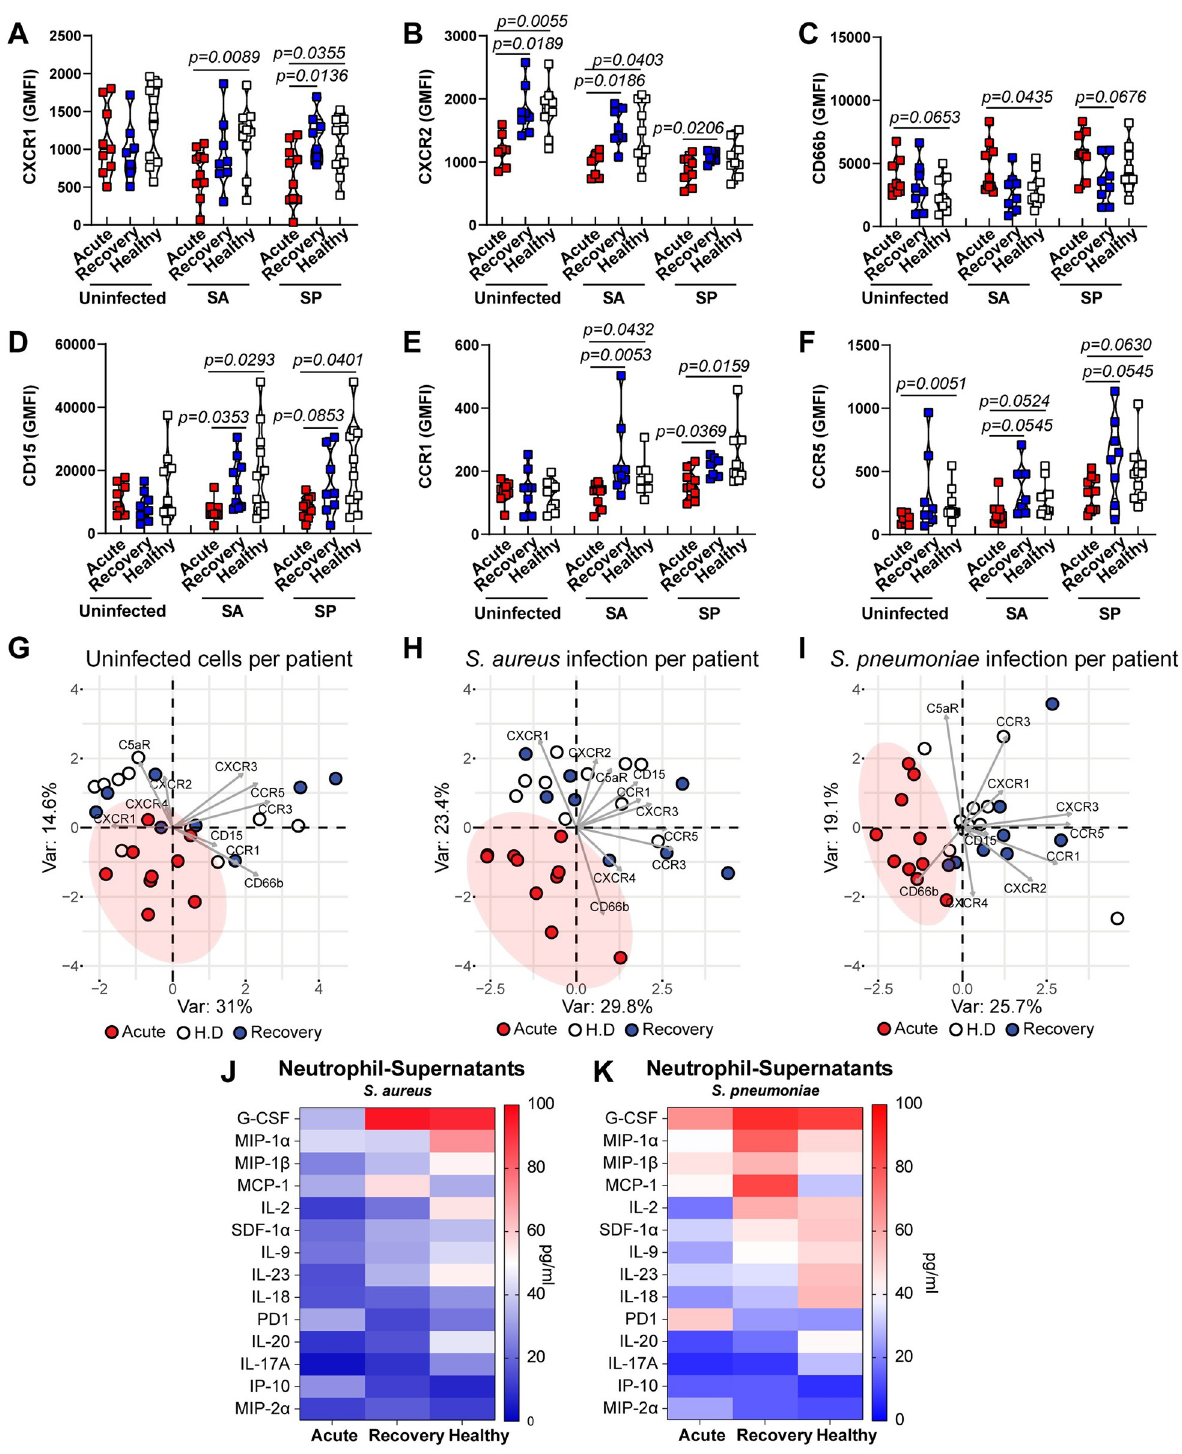
Fig 5. Expression of surface markers and secretion of cytokines in neutrophils upon bacterial challenge. ( A-F ) Expression of key surface markers of neutrophils from acute or rec-phase COVID-19 patients or healthy donors pre-exposed to 10% autologous plasma for 3 h and subsequently either challenged with SA or SP at MOI 1 or left unchallenged (n = 8–10). ( G-I ) PCA of cell surface phenotype of COVID-19 patients acute- (red) or rec- phase (blue) and healthy donors’ (white) neutrophils at the basal level without bacterial challenge ( G ), upon SA infection ( H ) or SP infection ( I ). Each symbol represents cells from a single COVID-19 patient or healthy donor exposed to either COVID-19 or healthy donor plasma. ( J and K ). Heat map of cytokines secreted by neutrophils from COVID-19 patients (acute- and rec-phase) and healthy controls after bacterial challenge with SA ( J ) or SP ( K ) (n = 3–4). For panels A-F, p values were determined by using Mann-Whitney test.